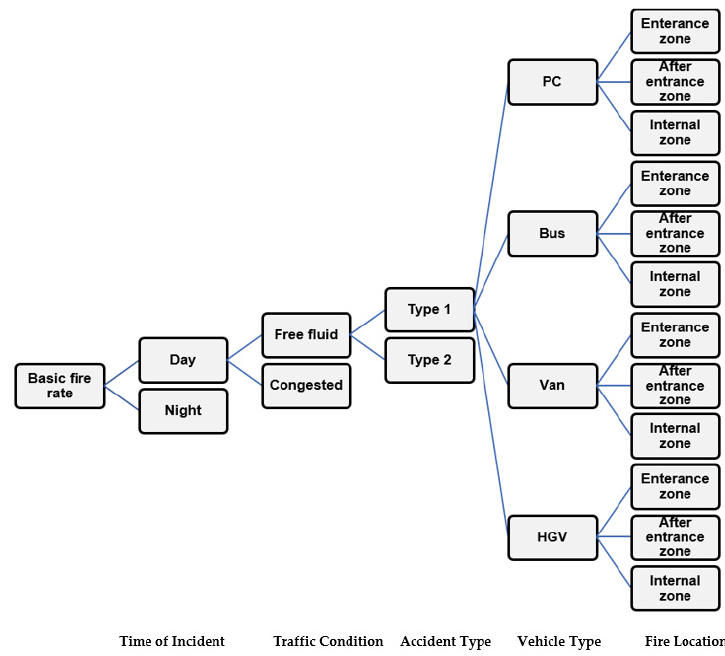
Figure 7. Illustration of a section of the frequency analysis event tree .